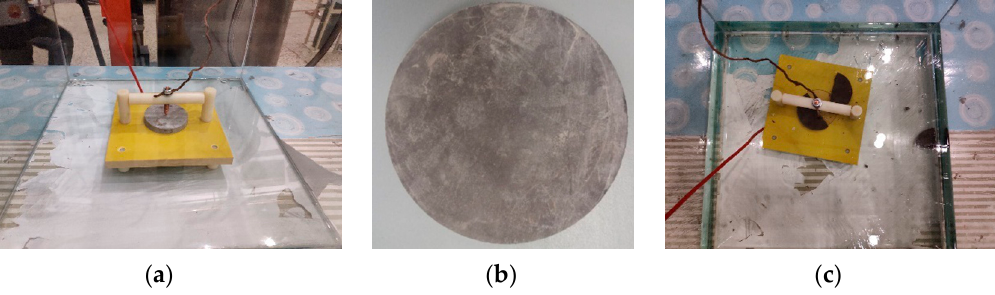
Figure 22. Test process. ( a ) Test sample installation; ( b ) Rock sample; ( c ) Test sample after experi- ment.